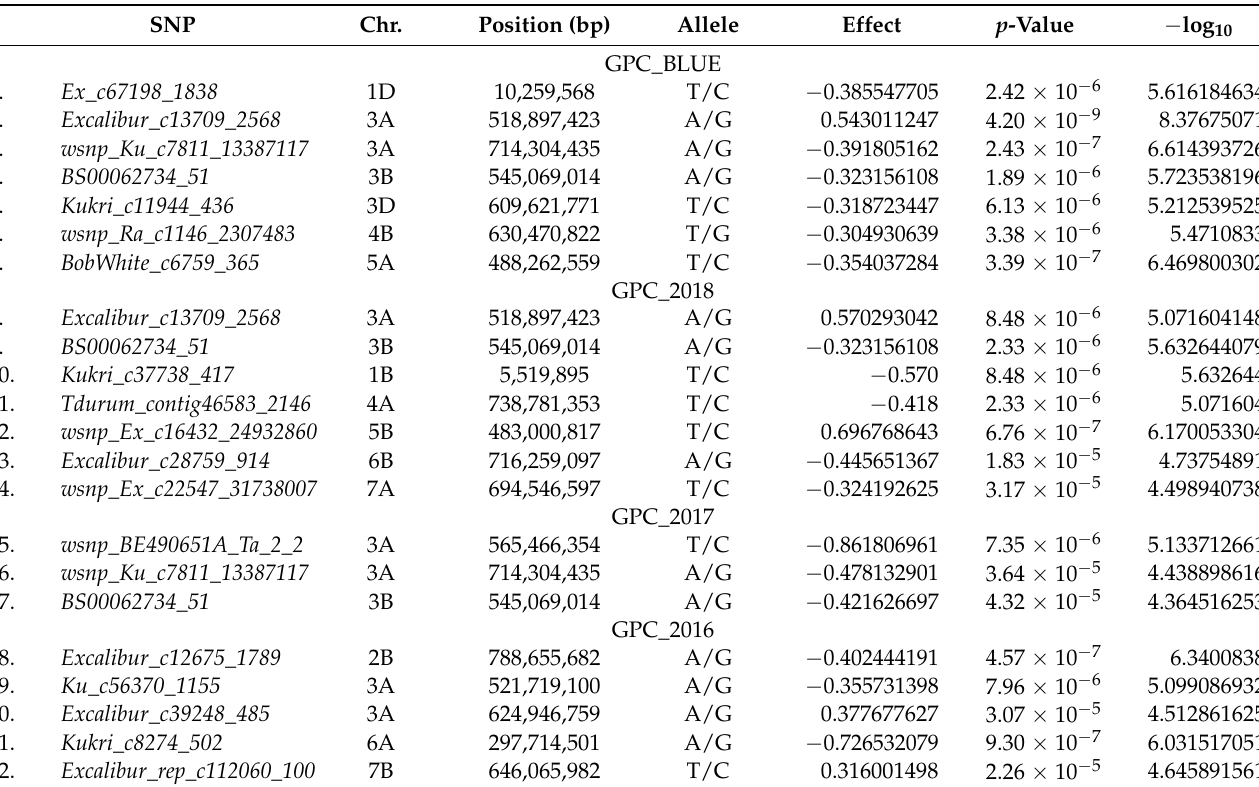
Table 1. Significant single nucleotide polymorphism (SNP) markers for grain protein content (GPC) in a diverse bread wheat population of 255 accessions, identified by the fixed and random